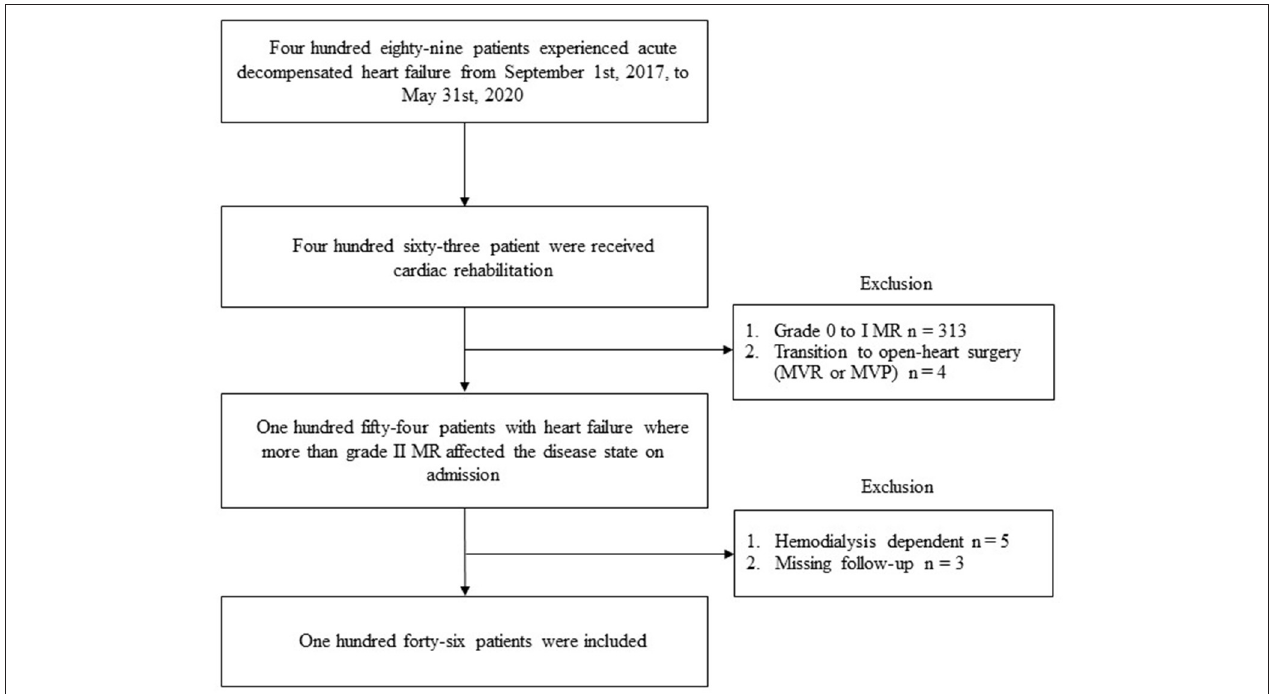
FIGURE 1 | The flowchart of the study in patients with heart failure harboring moderate-to-severe MR in the Yamaguchi Prefectural Grand Medical center. MR, mitral regurgitation; MVR, mitral valve replacement; MVP, mitral valvuloplasty.